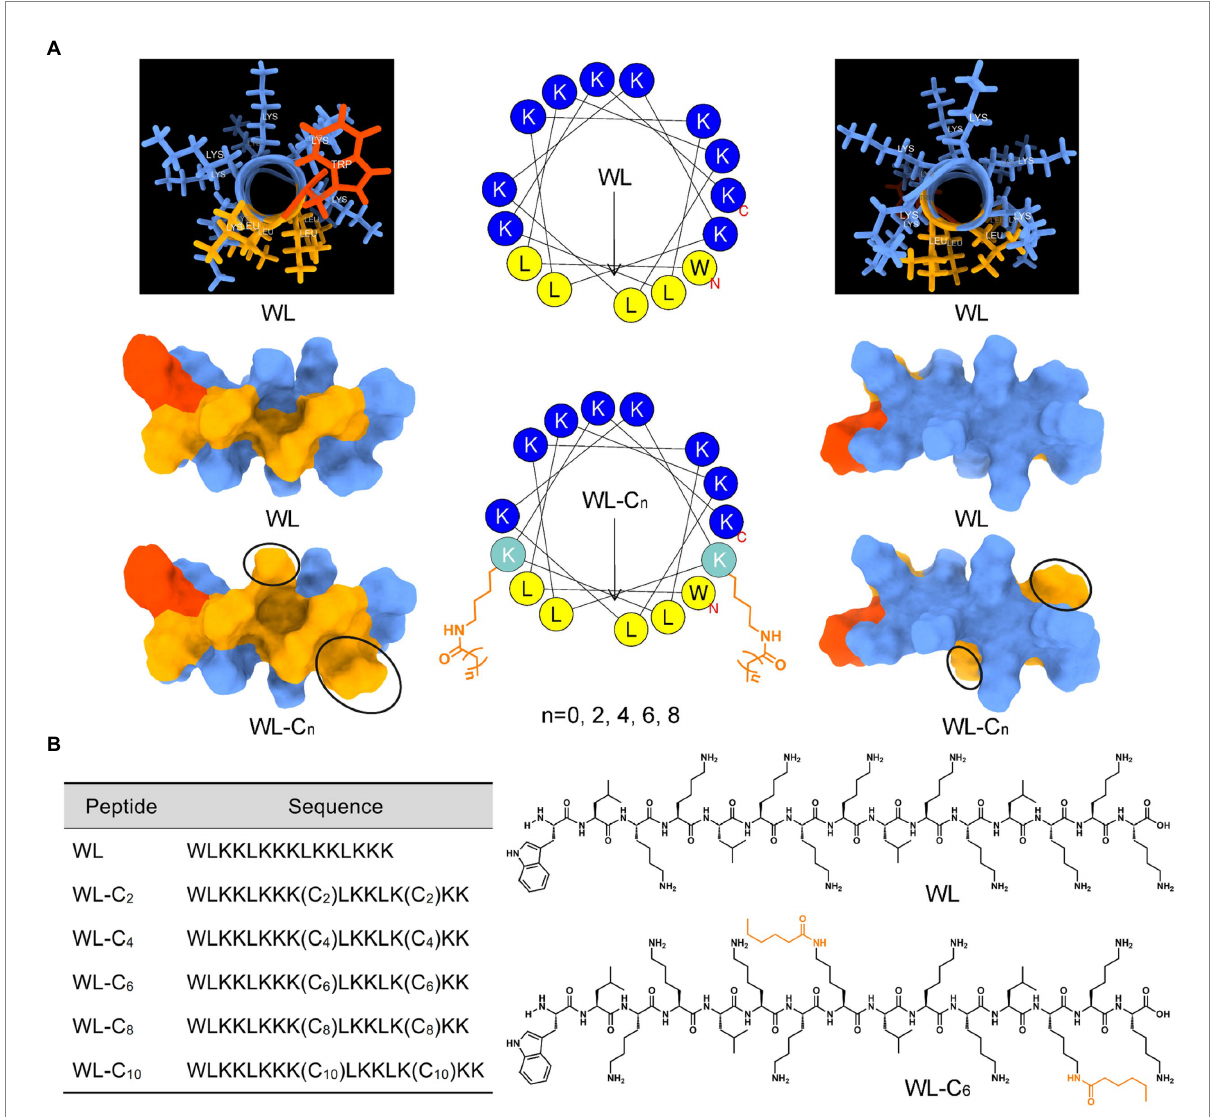
FIGURE 1 (A) Three-dimensional structure, helical wheel projections, and surface and ribbon views [hydrophobic faces (left) and hydrophilic faces (right)] of WL and WL-C 6 . (B) The sequences of WL and new lipidated peptides and the structural formula of WL and WL-C 6